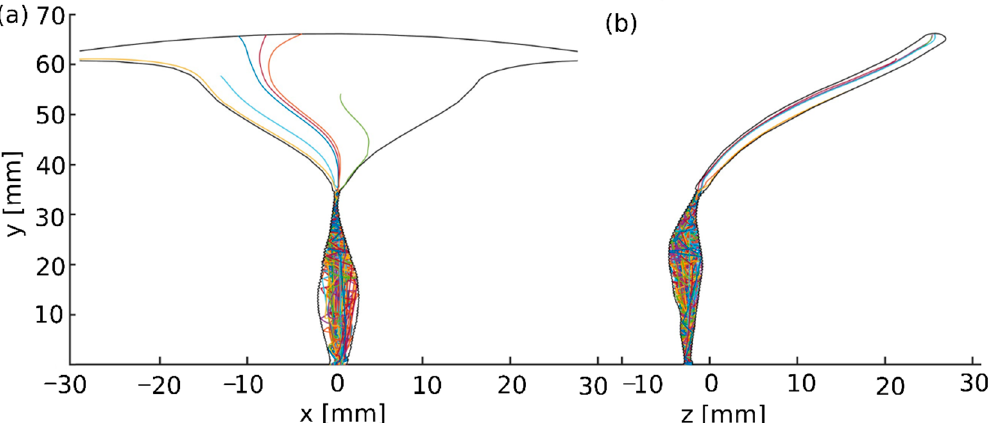
Figure 5 . Swimming patterns of the normal sperm cell models in the human female cervical canal and uterine cavity. Two-dimensional trajectories in the anterior view ( a ) and the sagittal view ( b ). Each line color indicates a single sperm model path.